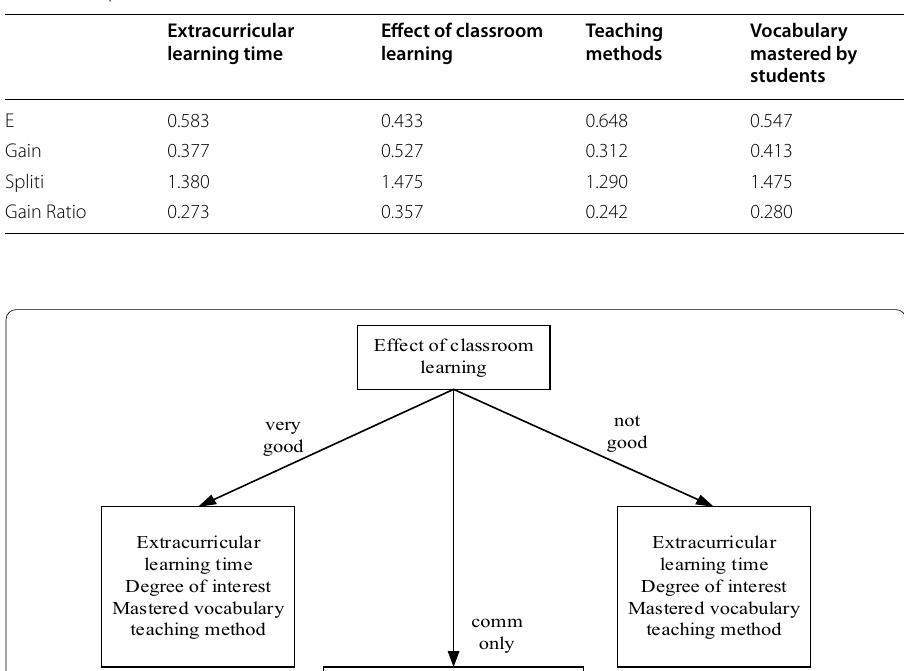
Table 2 Experimental result